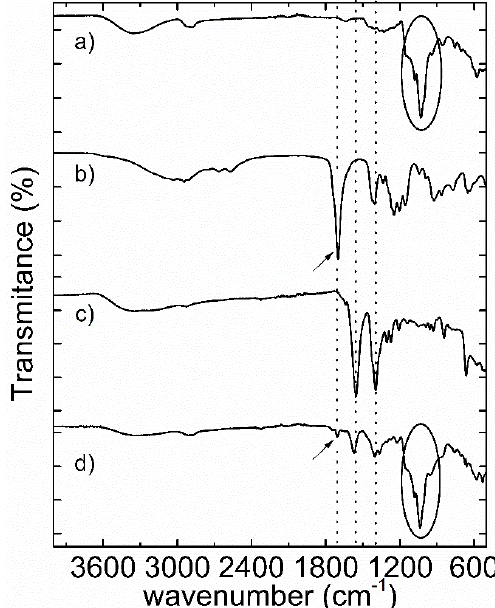
Figure 4. ATR-FTIR of βCDP ( a ) MPA ( b ) CdTe@MPA ( c ) and CdTe@MPA@βCDP ( d